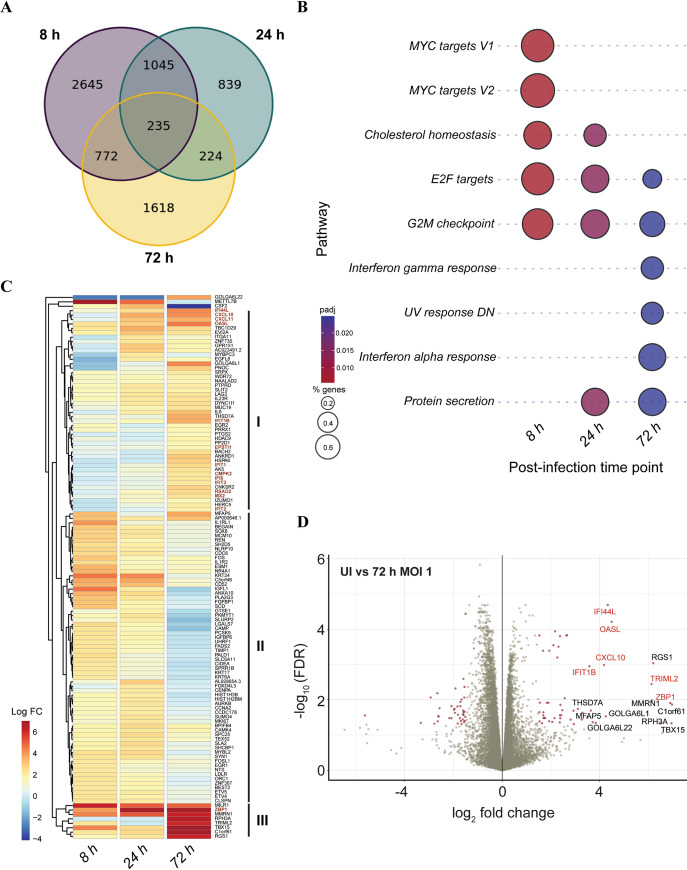
Transcriptional response to SARS-CoV-2 infection from NECs.(A) Venn diagram of shared or unique DEGs upon infection of NECs with wild-type SARS-CoV-2 at each of the indicated time-points. (B) Bubble-plot of top enriched Hallmark gene-sets upon infection of NECs with wild-type SARS-CoV-2. The color and size of each bubble is proportional to the adjusted p-value and the percentage of enriched genes from each gene-set, respectively. Only gene-sets with an adjusted p-value < 0.05 are shown (C) Heat-map of top 50 up-regulated DEGs observed at 8 h, 24h and 72 h after infection of NECs with wild-type SARS-CoV-2. Genes which correspond to Hallmark Interferon Alpha response, or Gene Ontology term Response to Type I Interferon are colored in red. (D) Volcano plot of genes at 72 h after infection of NECs with wild-type SARS-CoV-2. Significant DEGs with an adjusted p-value < 0.05 and log FC of at least 1.5 are indicated as maroon dots; all other DEGs are indicated as grey dots. The top 15 up-regulated genes by log FC are annotated, with interferon-stimulated genes annotated in red.